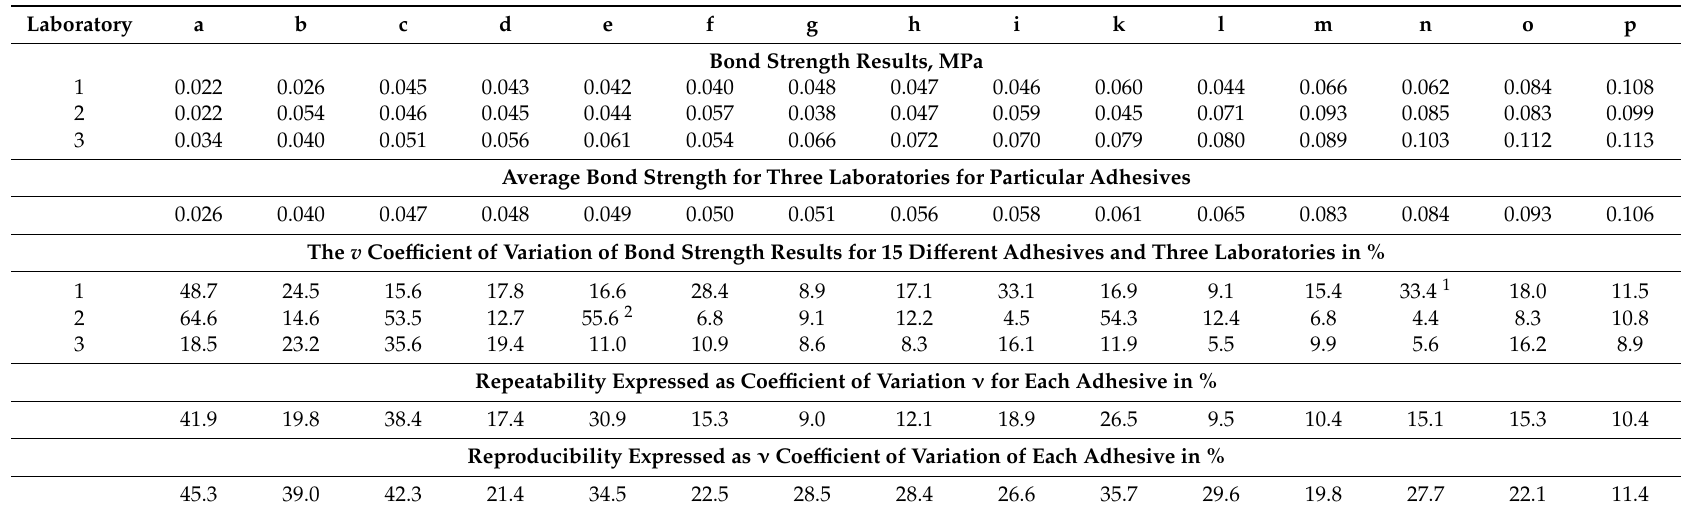
Table 1. Bond strength values, standard deviations of bond strength results for 15 di ff erent adhesives (marked as a–p in the first row) and three laboratories (marked as 1, 2, 3 in the first column). The individual laboratory variations, repeatability and reproducibility variations are given as the coe ffi cient of variation v.